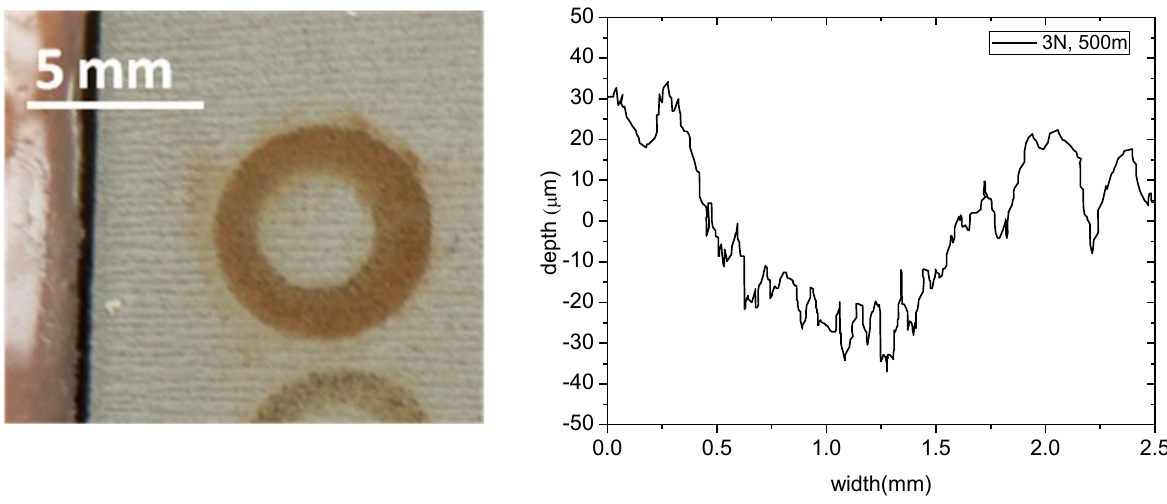
Figure 6. Appearance and profile of the wear track in a glass-ceramic sample after wear test against AISI 316 ball with a normal load of 3 N and sliding distance of 500 m.